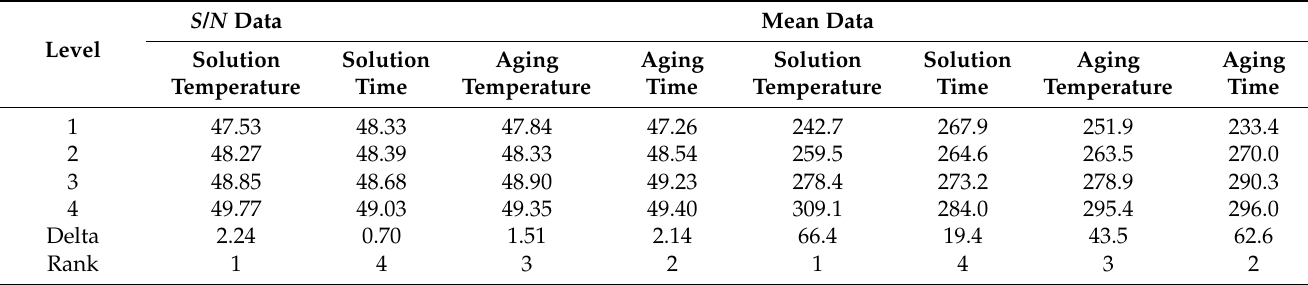
Table 6. Response table for signal-to-noise ratios (larger is better) and means for